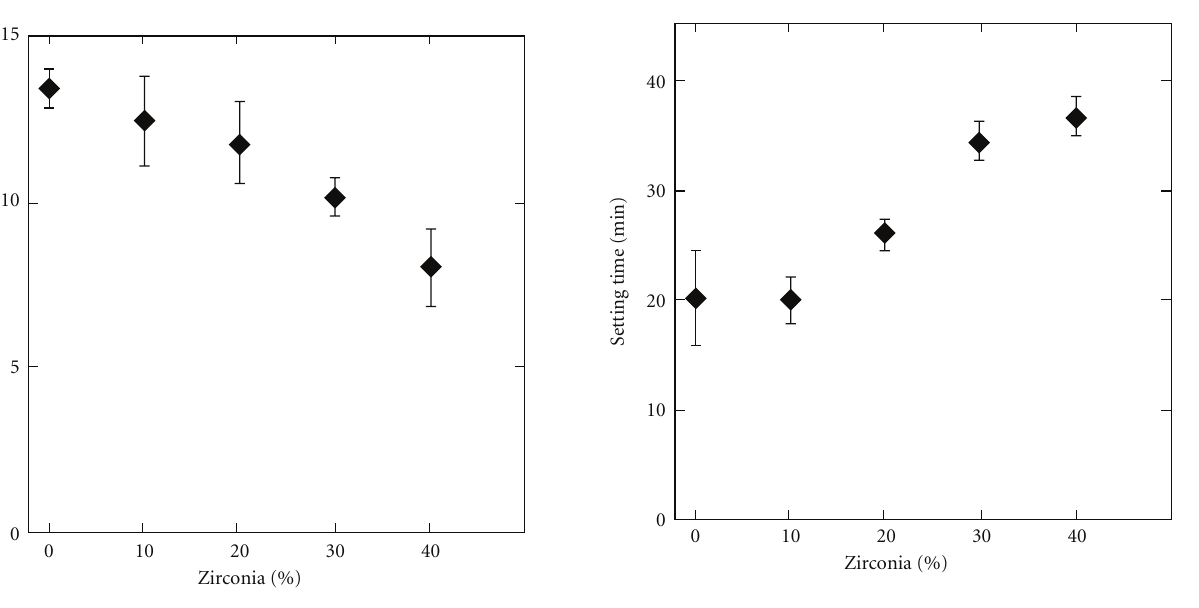
Figure 1: Diagram showing the influence of ZrO 2 content (0 to 40%) on compressive strength of the pCPC after 24 hours incubation in PBS at 37 ◦ C. Error bars represent standard deviation, n = 6.